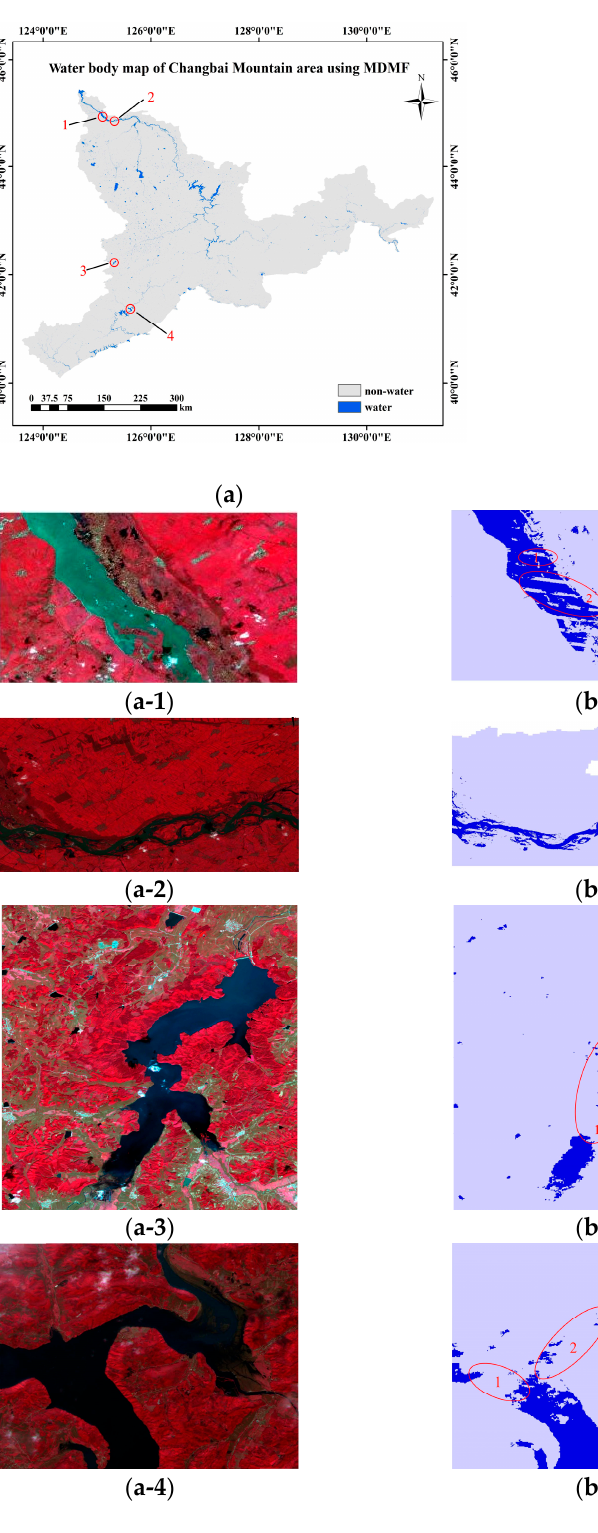
Figure 7. Water extraction results and enlarged view of water extraction results for the Changbai Mountain area. ( a ) Water results using the MDFM. ( b ) Water results of JRC-GSWE. ( a-1 – a-4 ) False color image of the circle 1 to circle 4. ( b-1 – b-4 ) JRC-GSWE water results of the circle 1 to circle 4. ( c-1 – c-4 ) Water results using the MDFM from circle 1 to circle